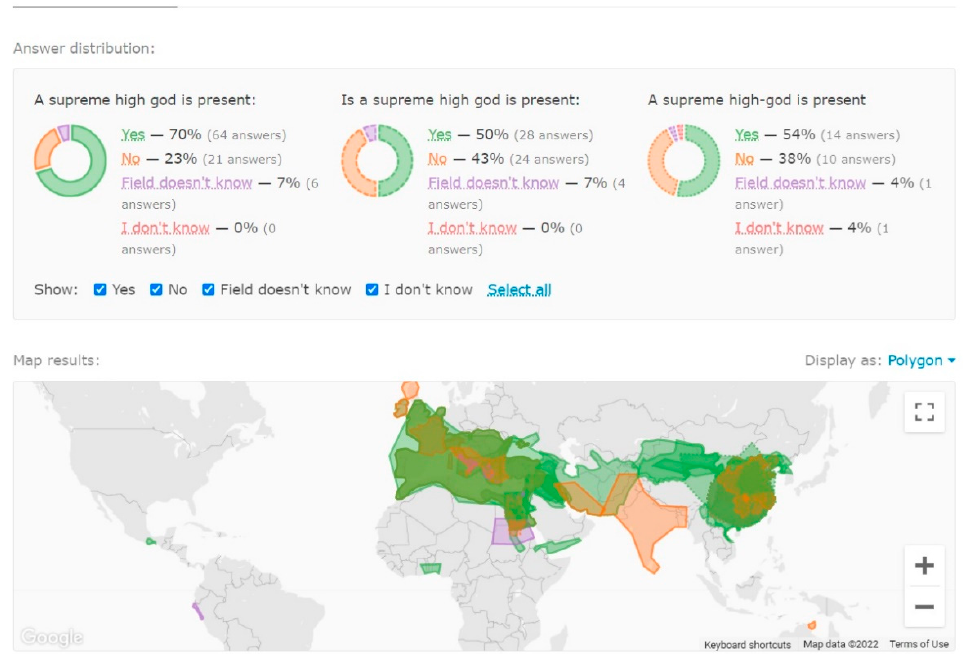
Figure 1. DRH visualization of the query “ A supreme high god is present ” from 5000–0 BCE. The pie charts represent the “Group”, “Place”, and “Text” polls, ordered from left to right.